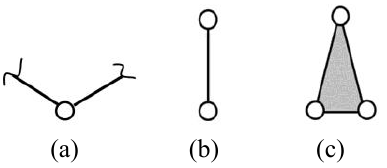
Figure 2. Graphical representation of generalized kinematic pairs and